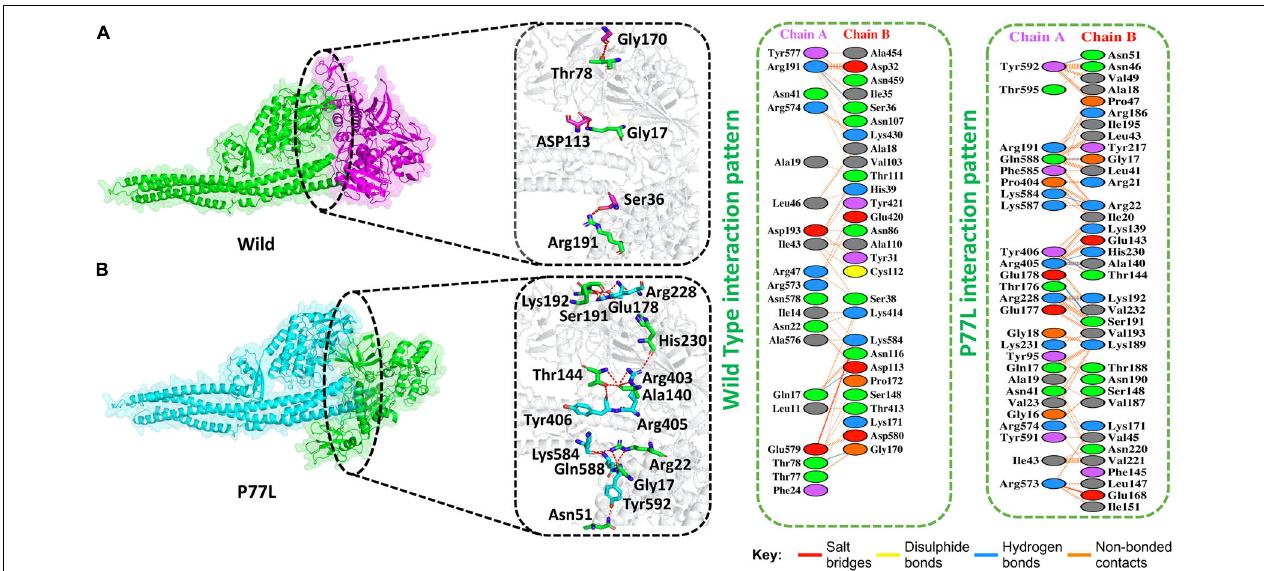
FIGURE 2 | Non-structural protein 13 WT and P77L mutant complex docking. (A) NSP13 WT and TANK binding kinase 1 (TBK1) key hydrogen bonding interactions with stick representations (left). Hydrogen bonds, non-bonded contacts, and salt bridges are shown by a 2D interaction (right). (B) P77L mutant and TBK1 key hydrogen bonding interactions along with their stick representation (left). Hydrogen bonds, non-bonded contacts, and salt bridges are shown by a 2D interaction (right).